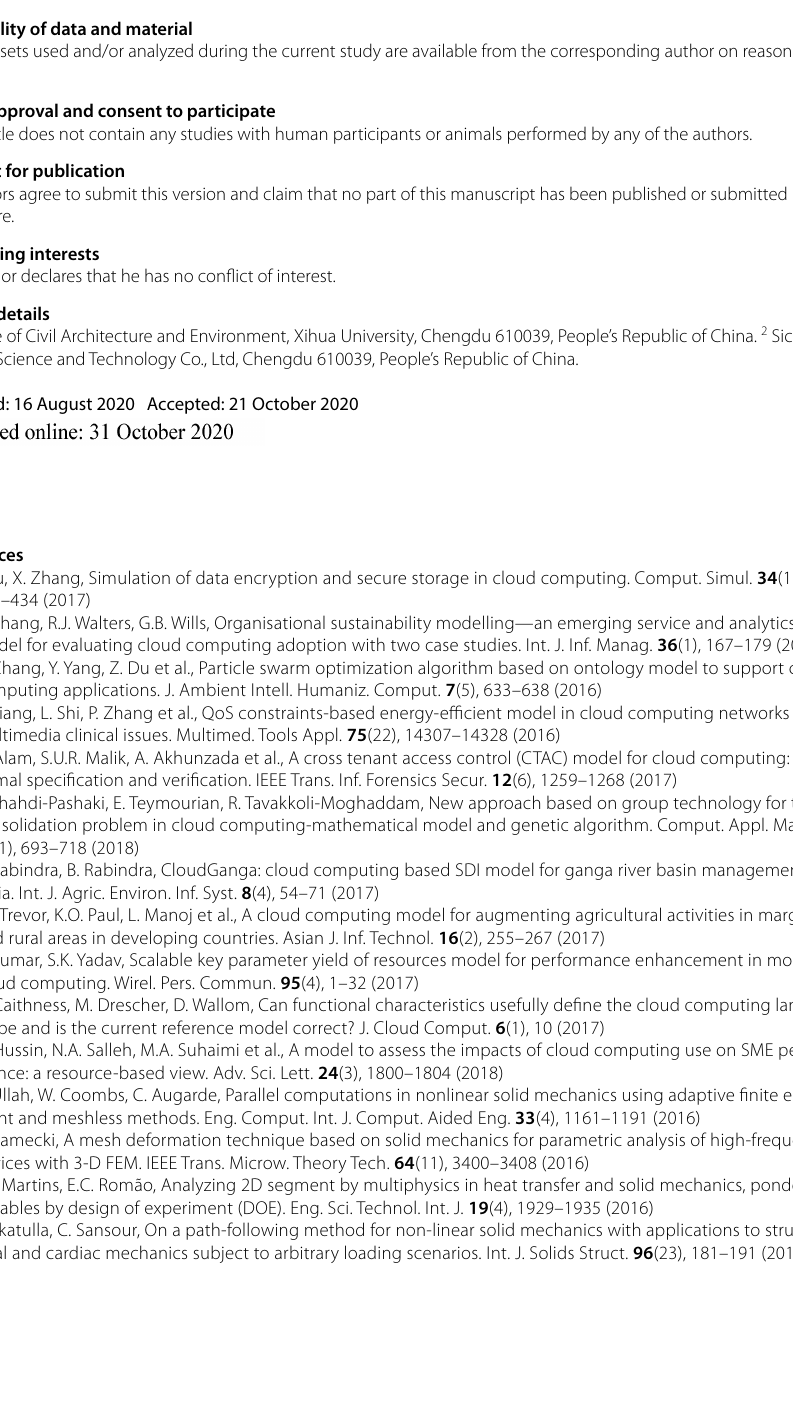
Abbreviation NSGA: Non-dominated sorting genetic